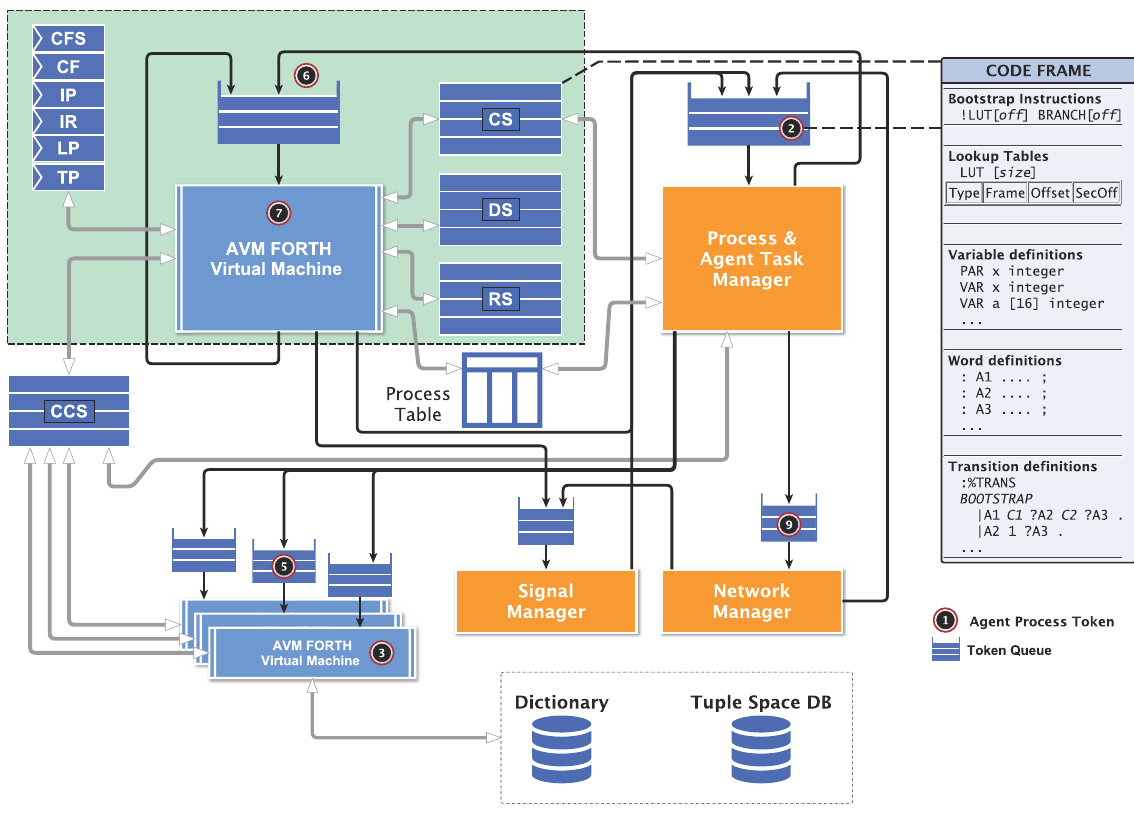
Figure 5. ( Left ) The agent processing architecture based on a pipelined stack